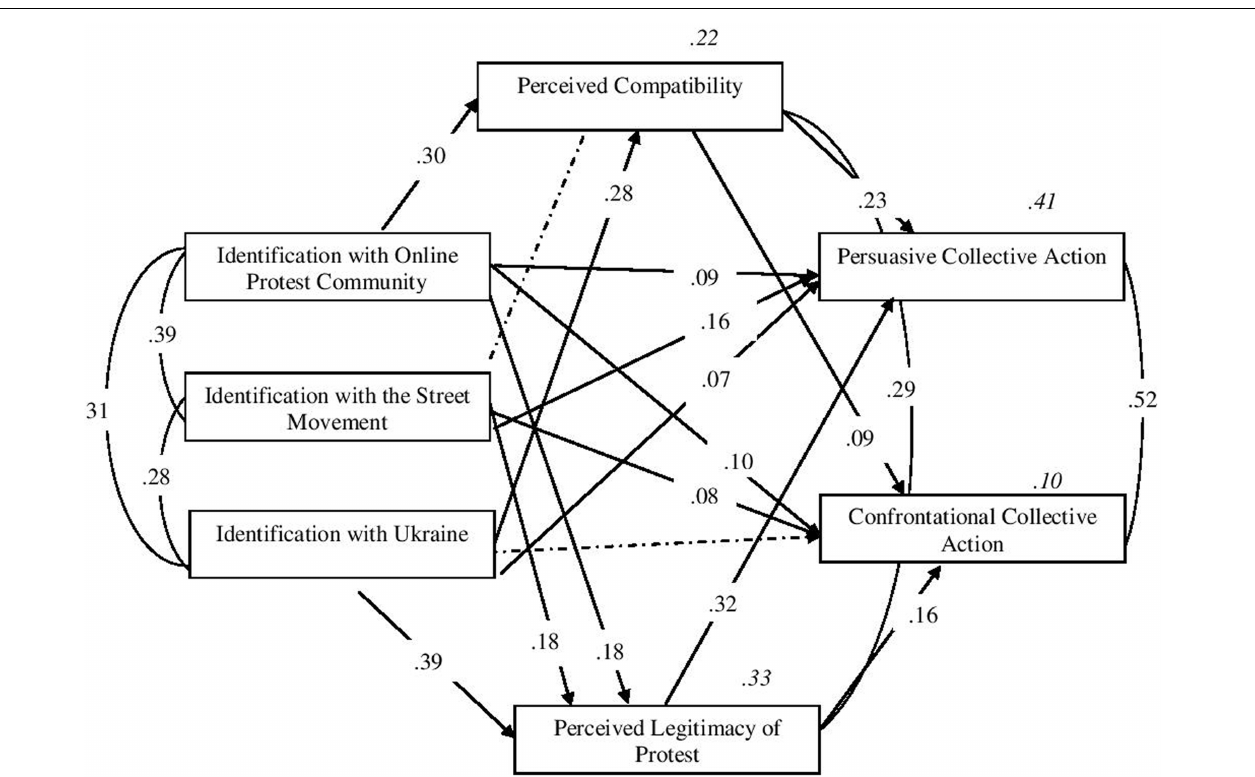
FIGURE 1 | Path analysis. Model for the pathways to persuasive and confrontational collective action via perceived compatibility and perceived legitimacy of protest. Figure contains standardized parameter estimates, all p < 0.001. Non-significant paths are shown as broken